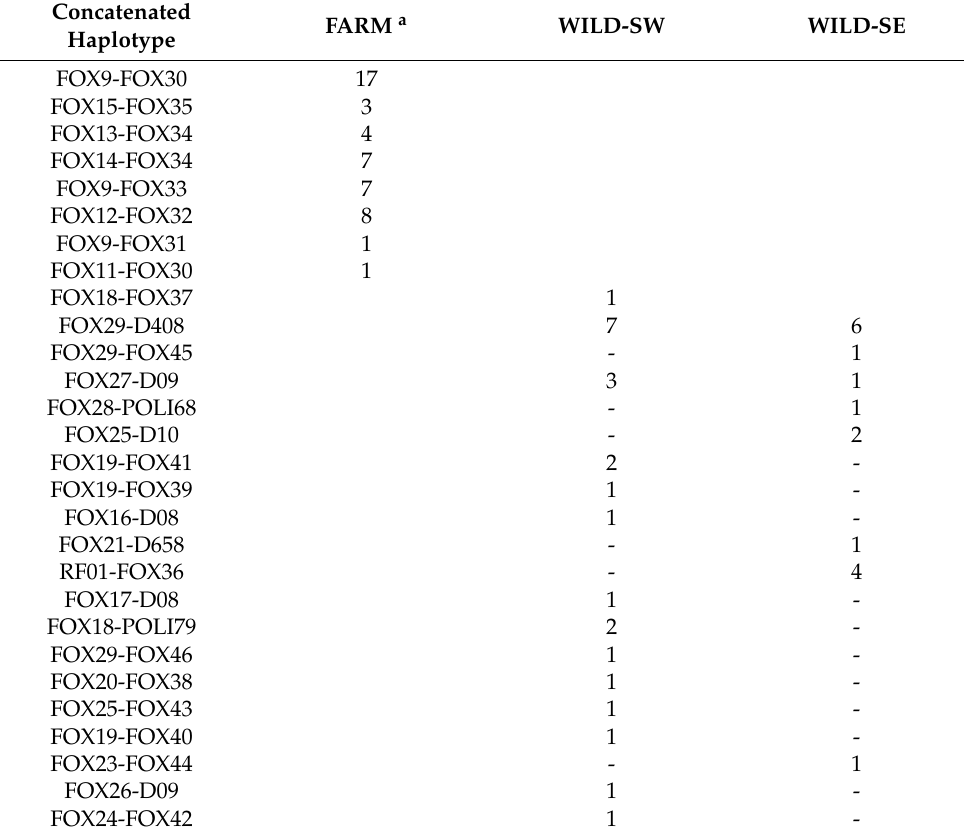
Table 1. Cytochrome b and D-loop concatenated haplotype frequencies in the studied red foxes. Concatenated FARM a WILD-SW WILD-SE Haplotype